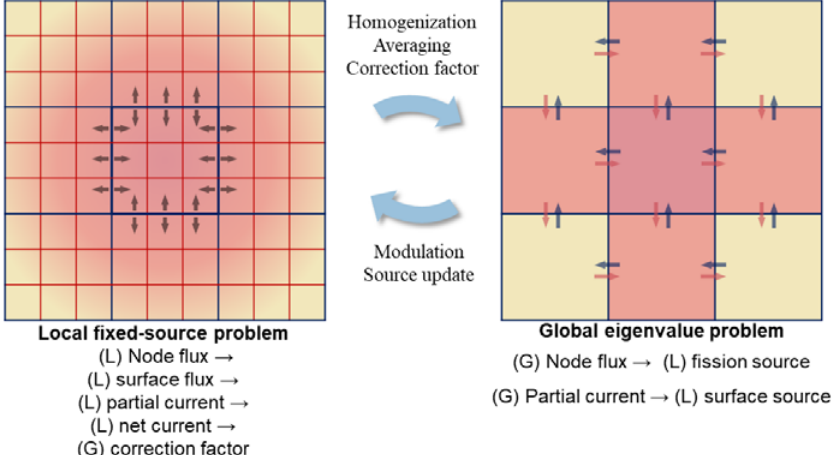
Figure 1. Diagram of FMFD method with 1-node CMFD method